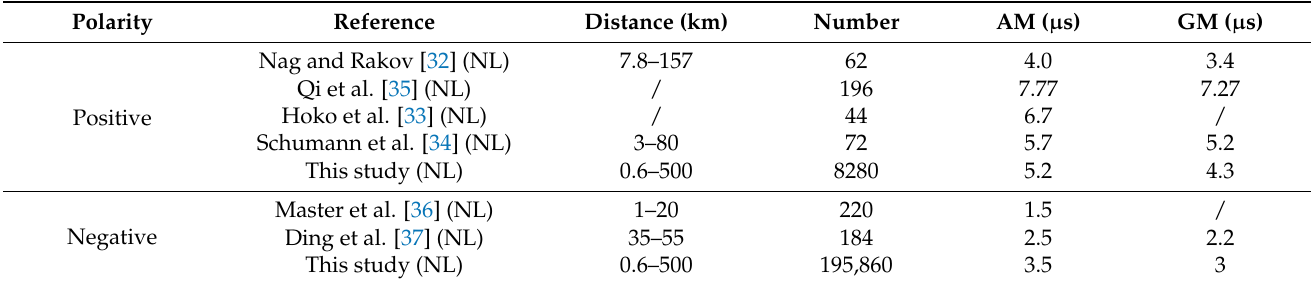
Figure 5. Histograms of rise time for RS pulses: ( a ) positive RS; ( b ) negative RS; Here, Min, Max, AM, GM, and SD are abbreviations for Minimum, Maximum, Arithmetic mean, Geometric mean, and Standard deviation, respectively. Table 1. Comparison of 10-to-90% rise time among different studies.